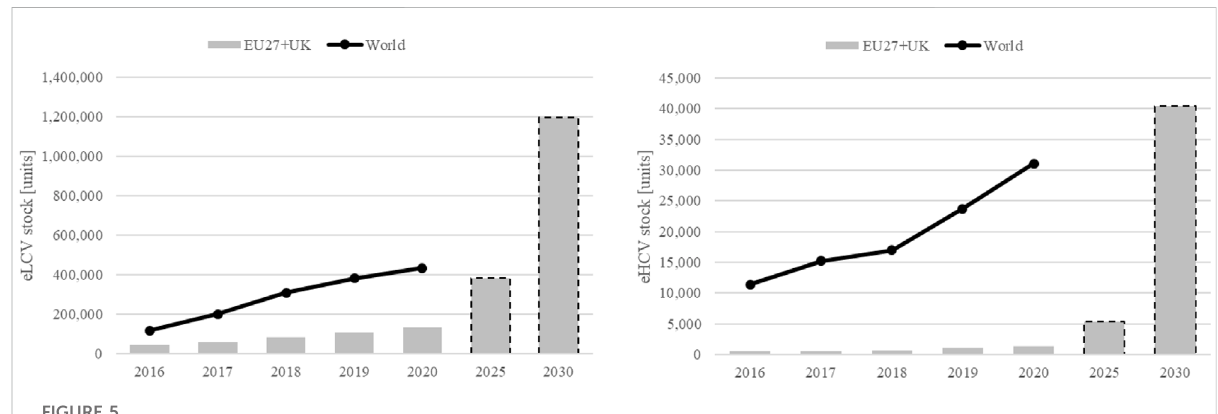
FIGURE 5 Electric LCVs and HCVs stock in EU27 + UK and the world and future estimates in EU27 + UK. Note: the 2025 and 2030 values result from summing the available estimates. Source: adapted from EC (2022), based on NIR, IEA (2021) and EAFO (2021)